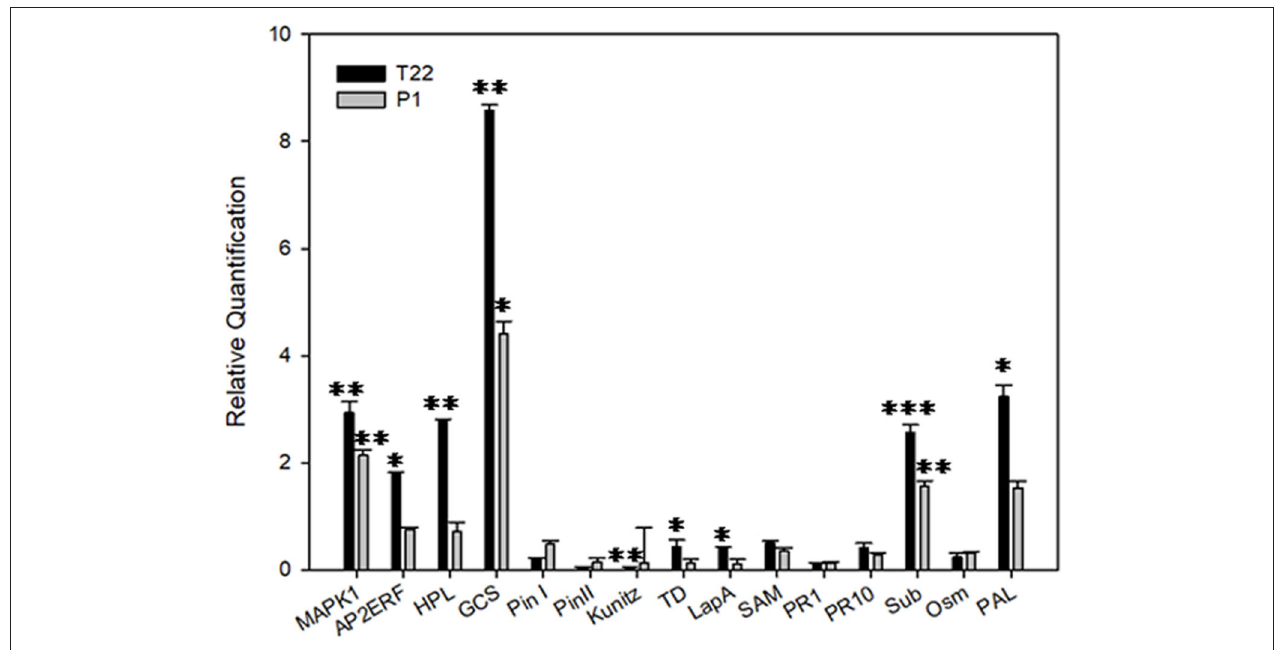
FIGURE 12 | Relative quantification of defense-related genes by real-time PCR (RT-PCR). Relative quantities (RQ) of defense genes in plants treated with T. afroharzianum T22 and T. atroviride P1 at 25 ◦ C. Data are calibrated to the CTRL sample (RQ = 1). Bars represent SE. Asterisks indicate statistically significant differences compared to the control condition (Student’s t -test, * P < 0.05; ** P < 0.01; *** P < 0.001). MAPK1 , Map Kinase 1; AP2ERF , Ap2 ethylene responsive factor; HPL , hydroperoxidelyase; GCS , germacrene C-synthase; Pin I and Pin II , wound-induced proteinase inhibitor I and II; Kunitz , Kunitz type proteinase inhibitor; TD , threonine deaminase; LapA , leucine aminopeptidase A; SAM , S-adenosyl methionine; PR1-PR10 , pathogenesis-related proteins 1 and 10; Sub , subtilisin; Osm , osmotin; PAL , phenylalanine ammonia